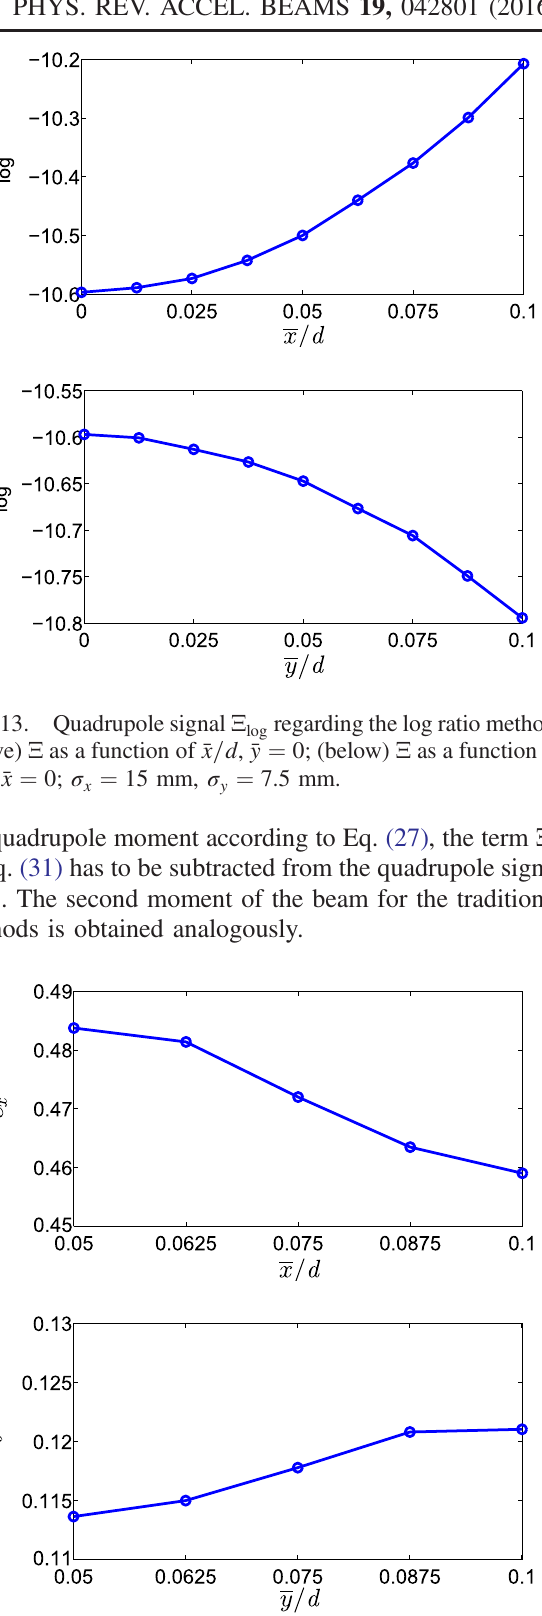
FIG. 14. Weighting factors c x and c y as a function of the beam position; (above) c x as a function of ¯ x=d , ¯ y ¼ 0 ; (below) c y as a function of ¯ y=d , ¯ x ¼ 0 ; σ x ¼ 15 mm, σ y ¼ 7 . 5